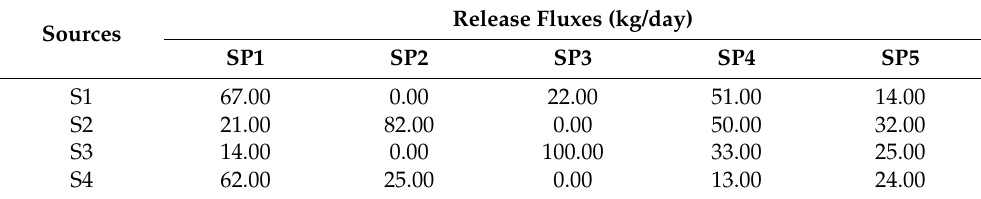
Table 8. The true release fluxes of the contaminant